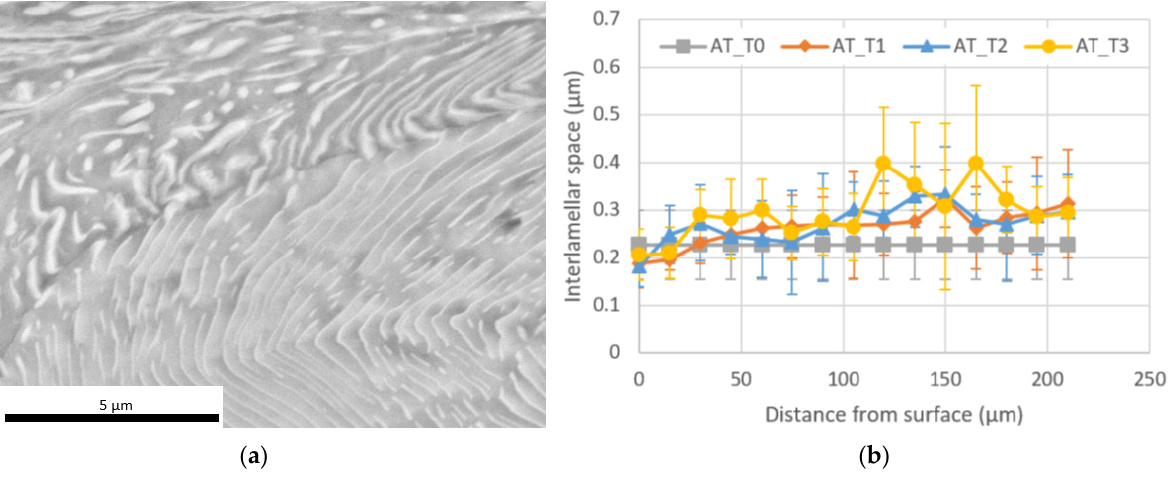
Figure 4. ( a ) SEM image of the pearlitic microstructure (AT-T0) and ( b ) interlamellar spacing for Ring AT. for Ring